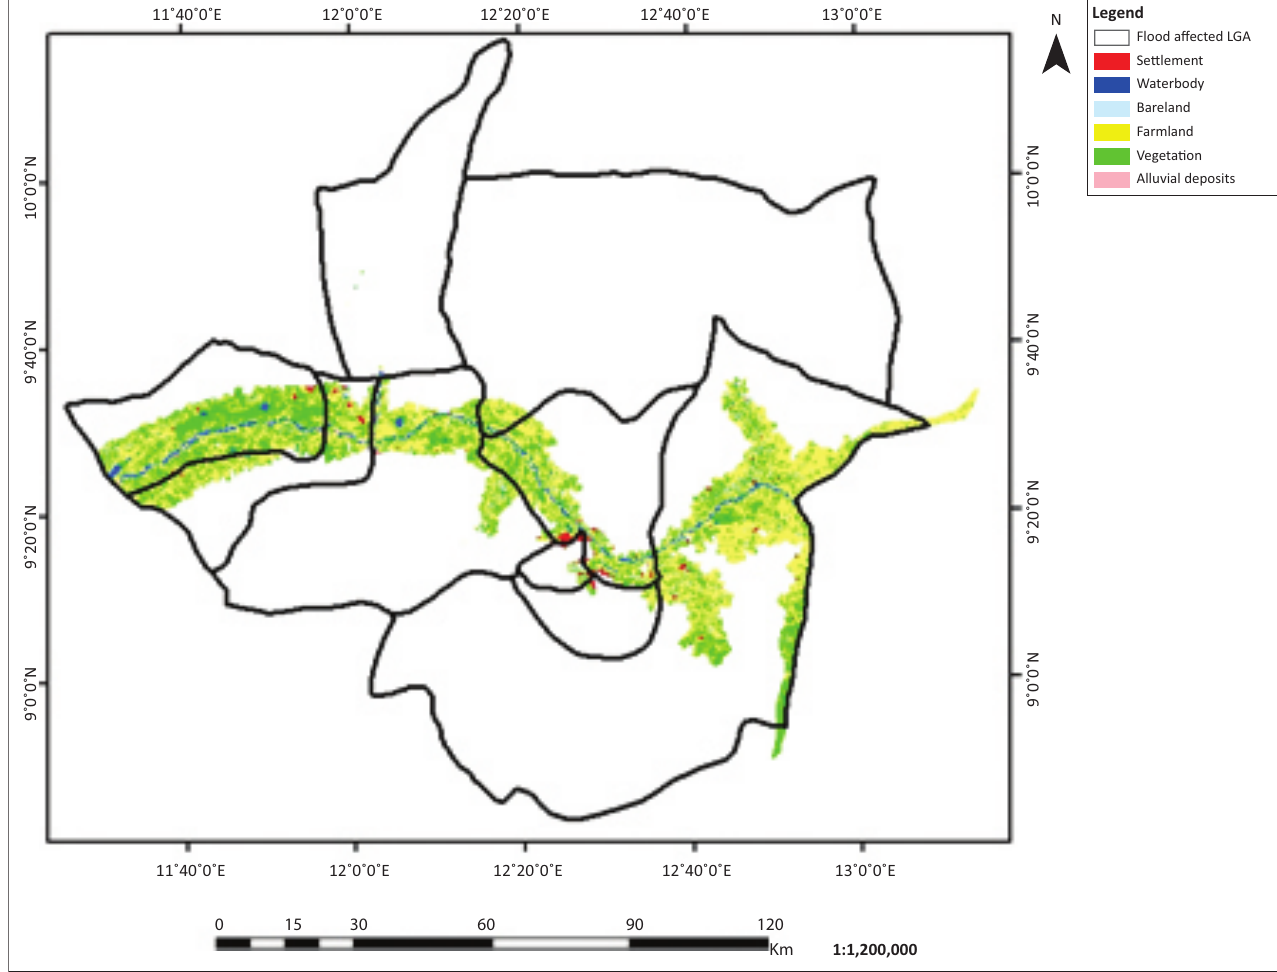
FIGURE 6: 2012 flooded land cover and/or land use in Adamawa